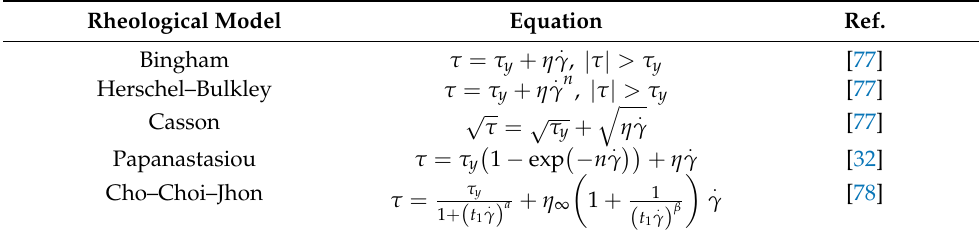
Figure 5. Schematic of the microstructure in a magnetorheological (MR) fluid before and after the application of an external magnetic field (Liu et al. [66], ©The Polymer Society of Korea and Springer Nature B.V., 2013. Table 2. Representative rheological models for viscoplastic yielding